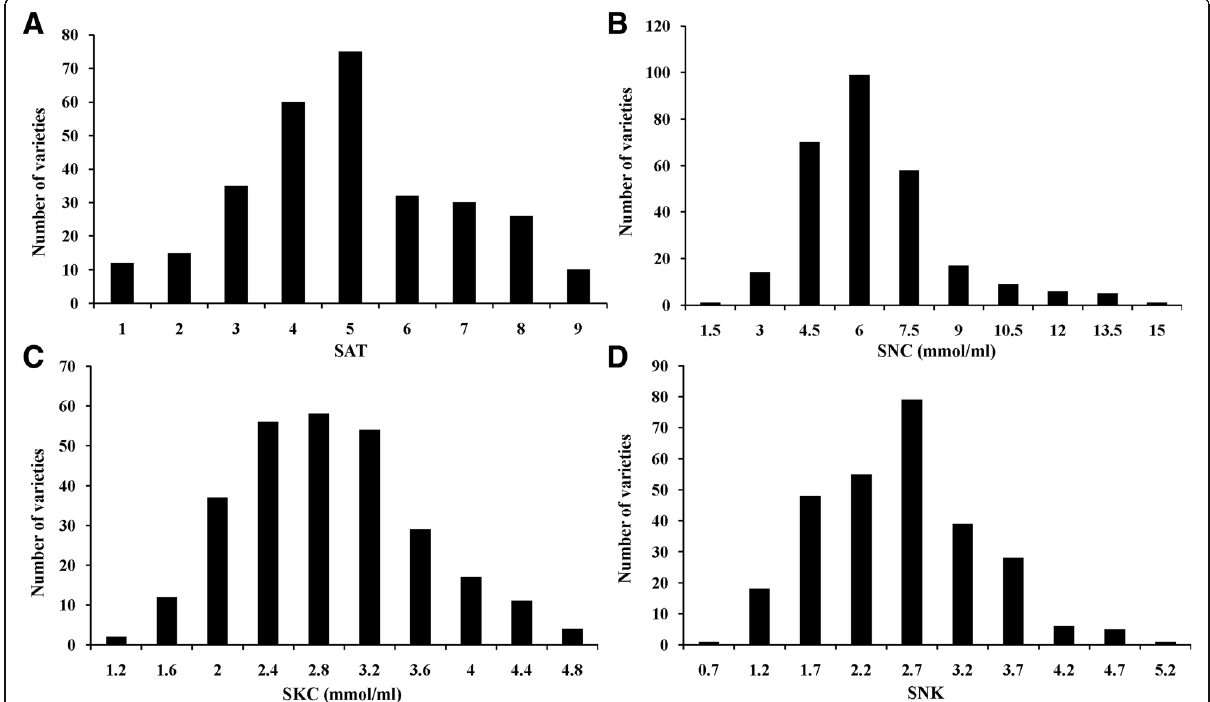
Fig. 1 Phenotypic variation in the SNC, SKC, SNK and SAT in 295 japonica rice varieties. a , The score of alkalinity tolerance (SAT). b , The concentration of Na + in the shoots (SNC). c , The concentration of K + in the shoots (SNC). d , The Na + /K + ratio of shoots